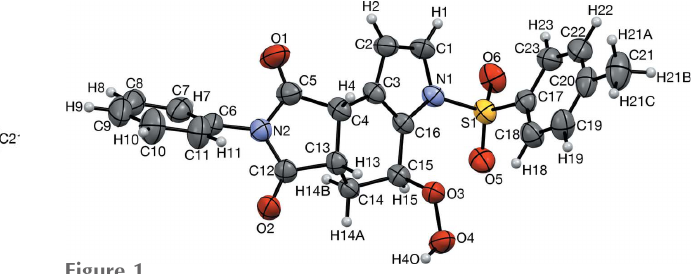
Figure 1 The molecular structure of (I) with displacement ellipsoids drawn at the 50% probability